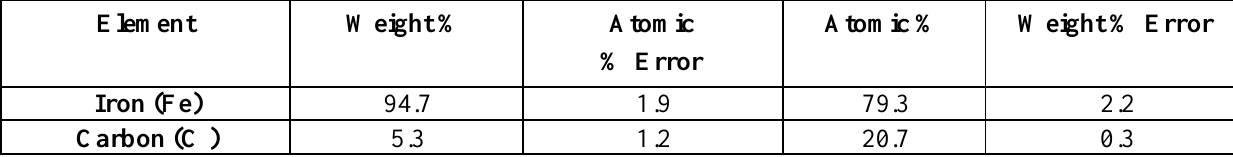
Figure 3: EDX spectrum of Fe plate before ablation by LPAIL. Table 2: Summarized the elements’ weight and atomical percentage of Fe plate by EDX before ablation process by laser in